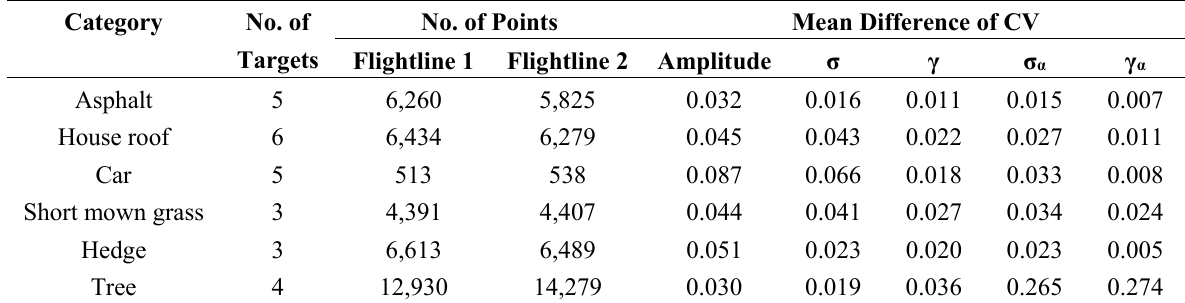
Table 3. Mean difference of coefficient of variation (CV) statistics of the backscatter parameters from overlapping flightlines before and after